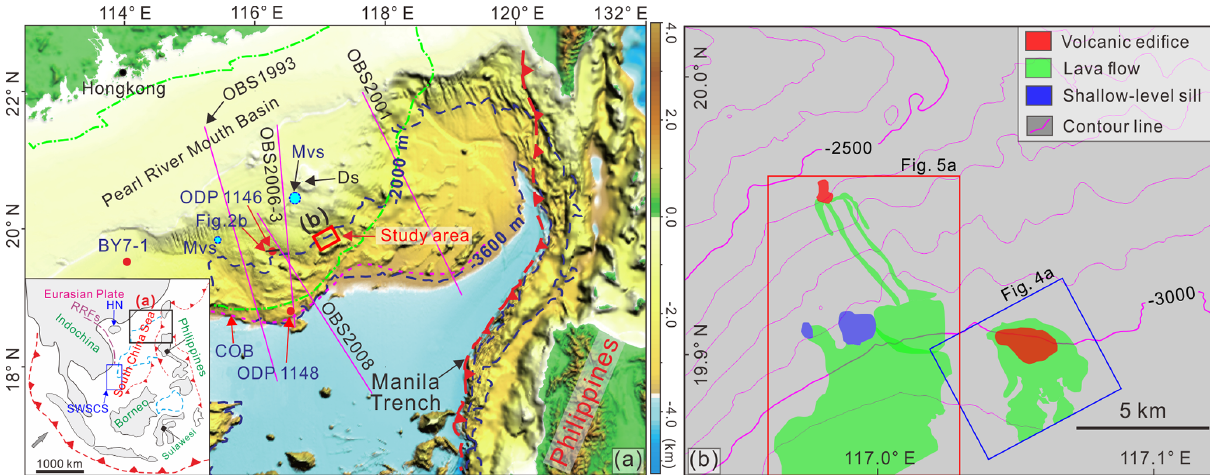
Figure 1. Geological setting of the study area. (a) Inset: regional setting of the South China Sea that is bounded by the Red River strike-slip faults (RRFs) to the west and by the subduction trench (Manila Trench) to the east. The island of Hainan (HN; Tu et al., 1991; Shi et al., 2011) and the southwestern South China Sea (SWSCS; Li et al., 2013) in which the magmatism has similar ages as the studied volcanoes labelled in blue. (a) The study area (marked with red square) is located to the south of Dongsha Islands (labelled Ds). The green dashed line outlines the boundary of the Pearl River Mouth basin. Locations of boreholes (red dots; exploration well BY7-1 and ODP sites 1146 and 1148), crustal structure profiles (purple solid lines; OBS1993, Yan et al., 2001; OBS2001, Wang et al., 2006; OBS2006-3, Wei et al., 2011; OBS2008, Chiu, 2010), and mud volcanoes (Mvs) (light blue dots; Sun et al., 2012; Yan et al., 2017) are labelled. Ds – Dongsha Islands; COB – continent–ocean boundary (adopted from Sibuet et al., 2016). The base map is modified from Yang et al. (2015); (b) seabed morphologies of the study area. Distributions of volcano edifices (red), sills (blue), lava flows (green), and locations of Figs. 4a and 5a are labelled. The contour lines are in 100ms (two-way travel